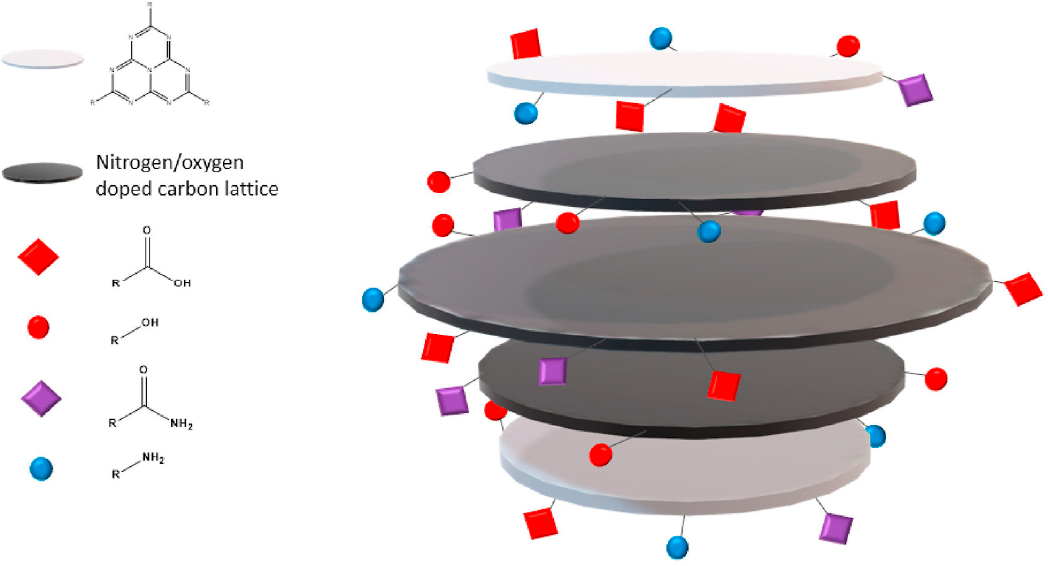
Figure 6. Schematic structure of CQNDs. Reprinted with permission from Min tz et al. [109].